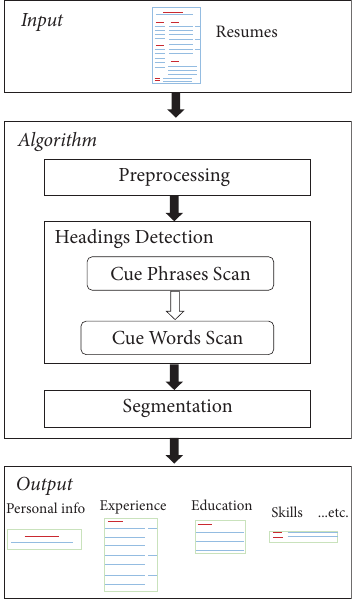
Figure 1: Te general architecture of the TSHD